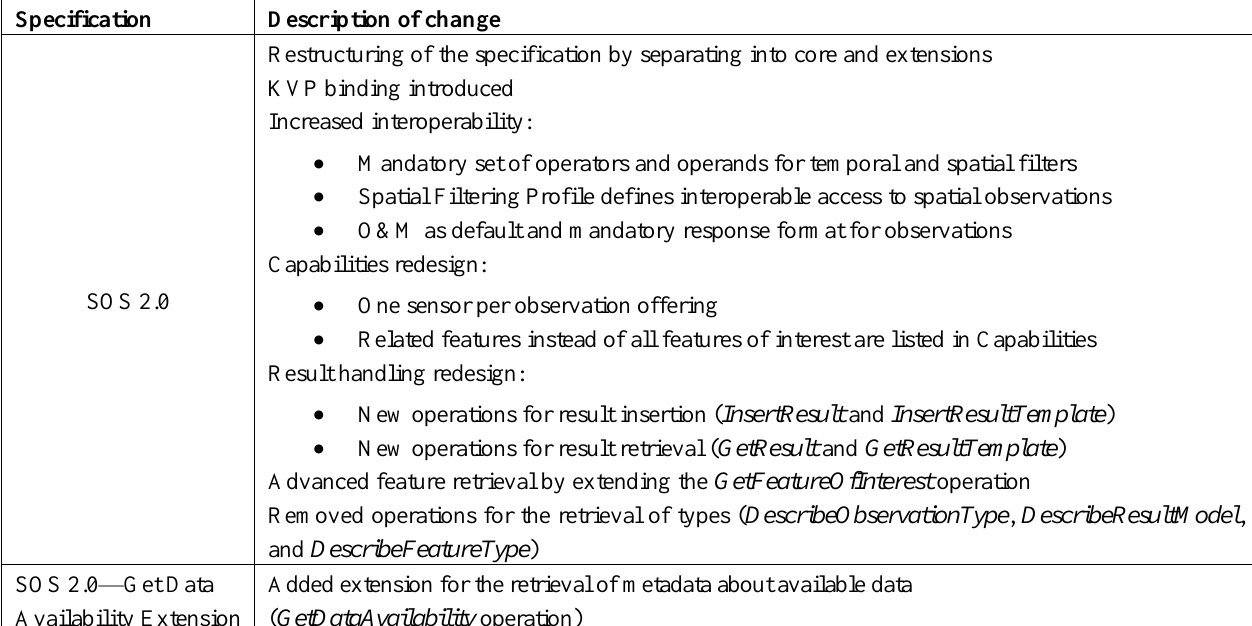
Table 3. Major changes of SOS